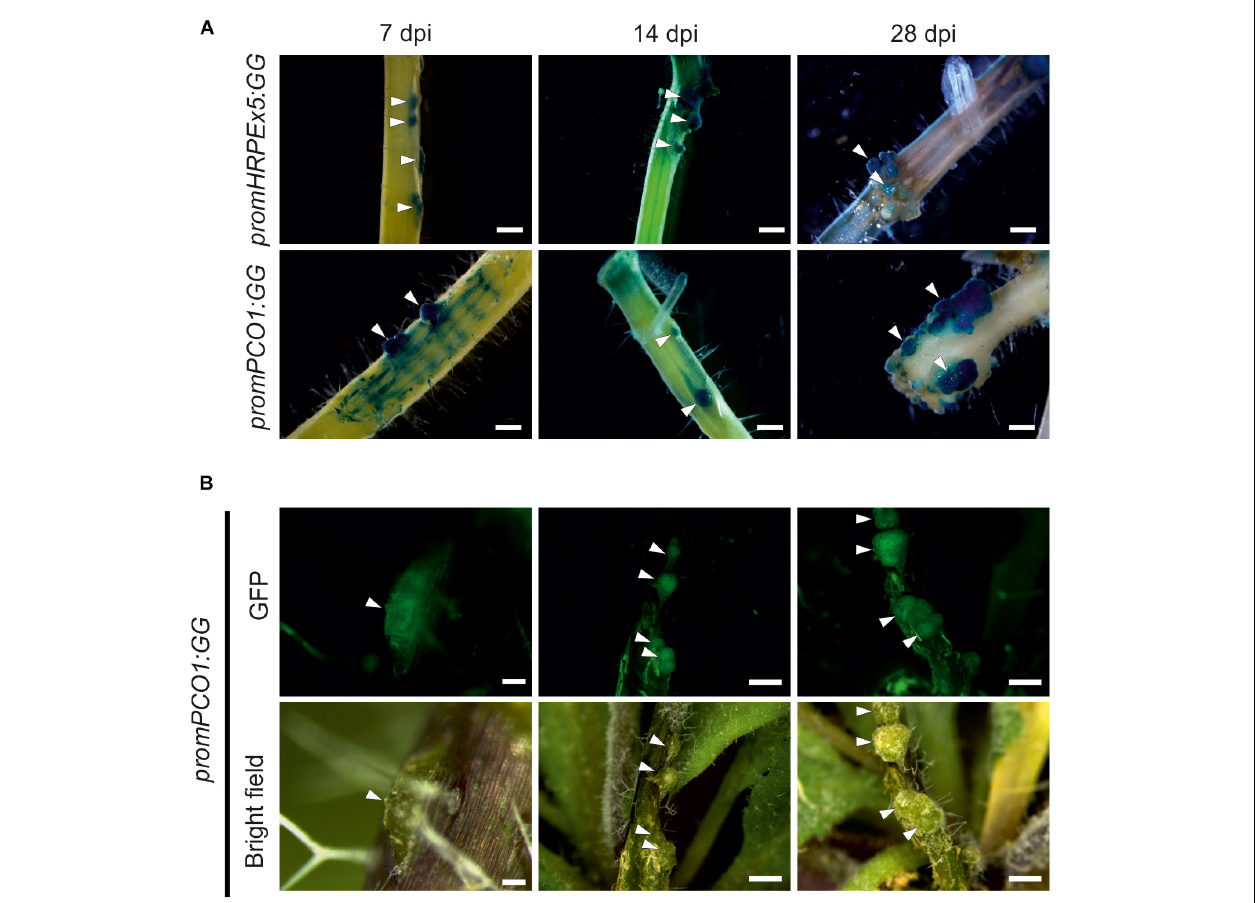
FIGURE 2 | The low oxygen reporter gene PCO1 and the hypoxia inducible promoter HRPEx5 are specifically induced in crown gall tumors at different development stages. (A) Histochemical GUS staining of promPCO1:GG and promHRPEx5:GG infected with A. tumefaciens . Staining was performed at 7, 14, and 28 dpi. Arrows indicate crown gall formation on the stem. (B) GFP fluorescence and bright field images of crown galls, harboring the promPCO1:GG construct. GFP imaging was performed at 7, 14, and 28 dpi. Scale bars indicate 100 µ m for promPCO1:GG at 7 dpi, all other scale bars indicate 1